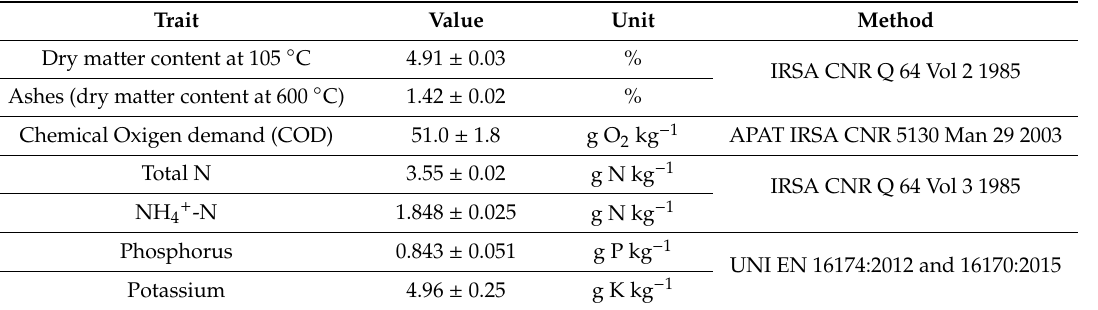
Table 1. Composition of the digestate liquid fraction used for the test. Values are means ± s.d. (3 subsamples) provided by the management o ffi ce of the digester. The analyses were made on the digestate liquid fraction hydrocyclone